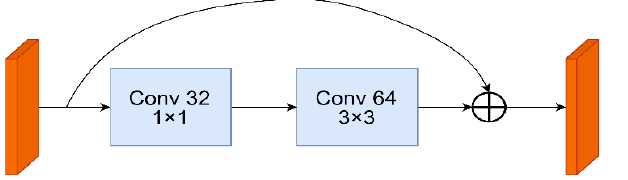
Figure 2. The structure of the residual network.